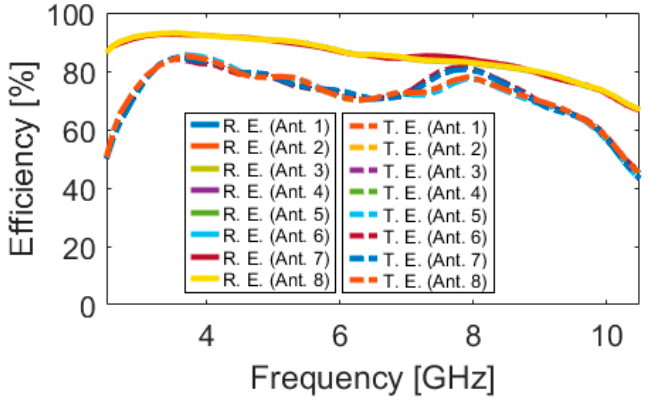
Figure 18. Efficiencies of the MIMO design. Figure 18. E ffi ciencies of the MIMO